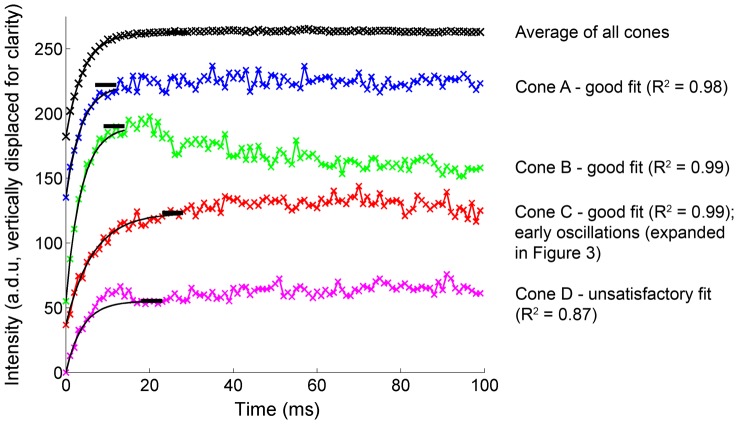
Representative data to illustrate curve fitting.Raw intensity from selected cones is shown (coloured crosses) together with the average of all cones (black crosses). Intensity traces are displaced vertically for clarity. After estimation of plateau intensity (black bars) from the raw data, an exponential fit was obtained (smooth black lines). The quality of fit was good (R2>0.95) for the average and for cones A, B and C, but unsatisfactory (R2<0.95) for cone D.